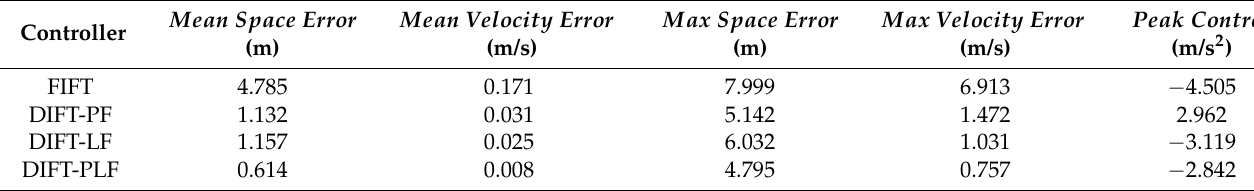
Figure 14. Acceleration error. Table 2. Control parameters in